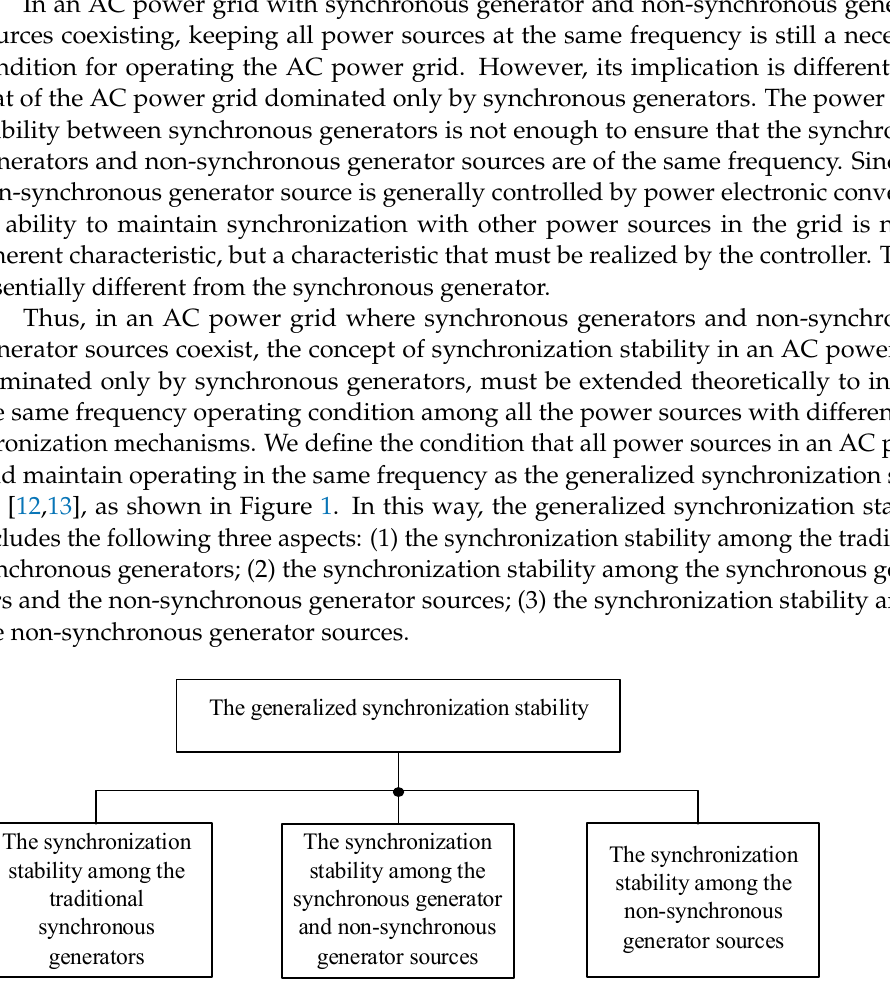
t    Figure 2. Typical structure of a non-synchronous generator source. The external characteristic of the grid following converter source is of the current source [16], and it must be connected to an active grid. The control strategy of the grid following converter source is to control the amplitude and phase angle of the current in- jected to the grid by the converter. The grid following converter source can be a voltage source converter or a current source converter; the typical representatives are the tradi- tional line commutation converter (LCC) [17], the doubly fed induction generator (DIFG) [18] and the voltage source converter with AC current direct control [16]. For the grid following converter source, the basic means to keep synchronization with the grid power source is to use the phase-locked loop (PLL) to track the phase angle of its grid side voltage u s . Figure 3 shows the schematic diagram of a PLL based on the synchronous reference frame (SRF-PLL) [16].